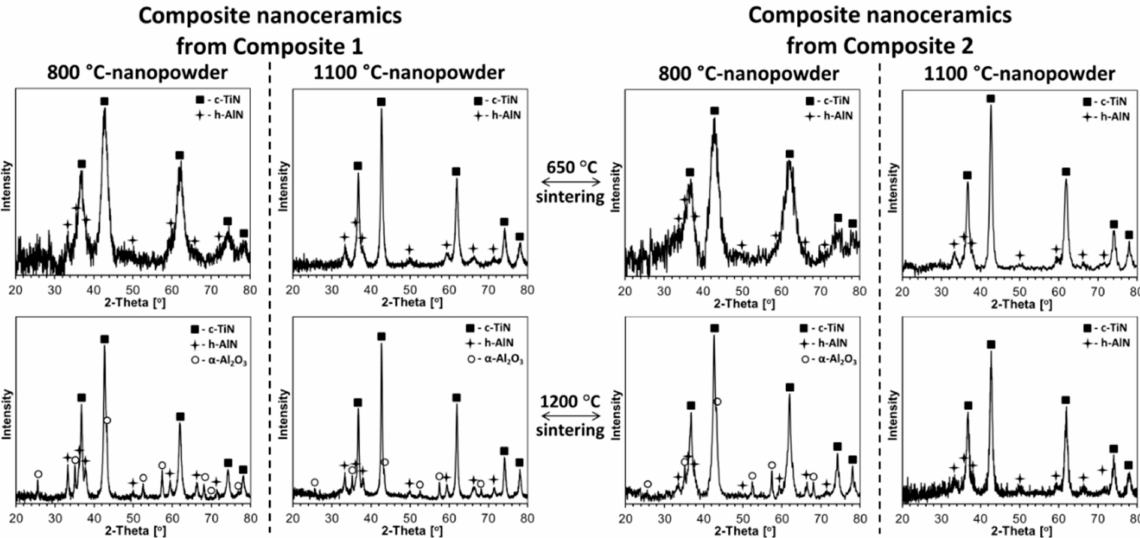
Figure 8. XRD patterns of composite nitride nanoceramics sintered from nanopowders of Composite 1 ( left panel ) and Composite 2 ( right panel ) at 650 and 1200 ◦ C, 7.7 GPa.